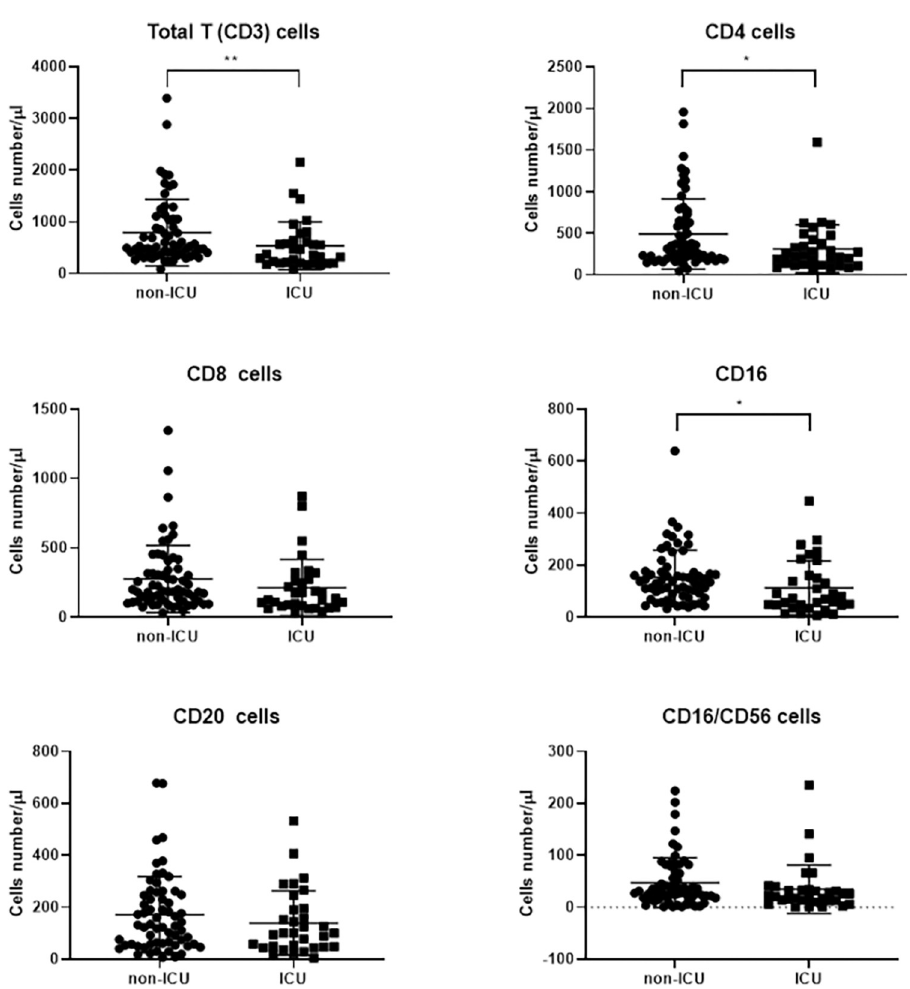
Fig 2. Impact of SARS-CoV-2 infection on T, B and NK cell numbers in severe and moderate patients ( � P < 0.05, �� P < 0.01). Immunological markers were analyzed in 32 severe cases compared with 63 moderate cases. CD3 + , CD4 + cells and Fc γ RIII (CD16) had a significant difference between the two groups. Due to the poorer prognosis with an increase in neutrophils that have Fc γ RIIIB and insignificant changes in NK cell count, the increase in CD16 is due to the increase in peripheral blood monocytes in patients with COVID-19.